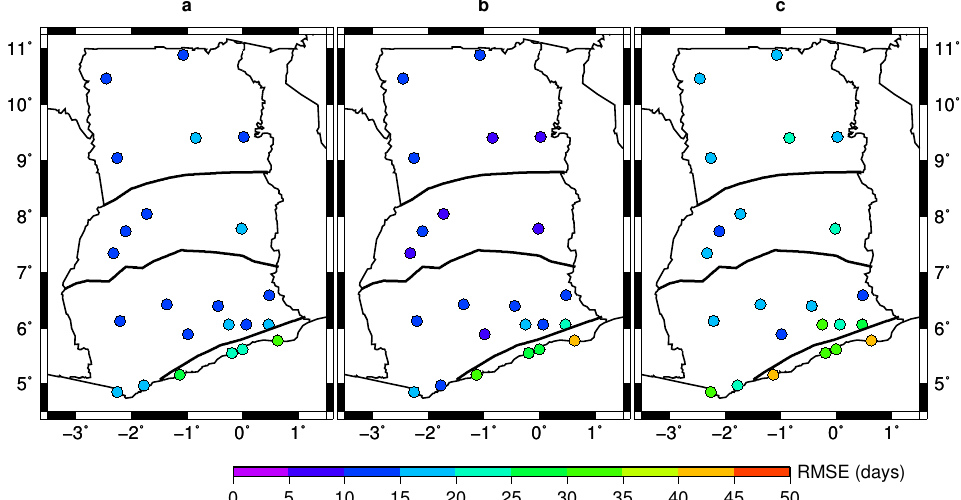
Figure 5. Map showing the RMSE between the number of rainy days and rainfall amount. ( a ) RMSE of rainfall onset, ( b ) RMSE of cessation and ( c ) RMSE of the length of the rainy season for the 23 GMet stations in